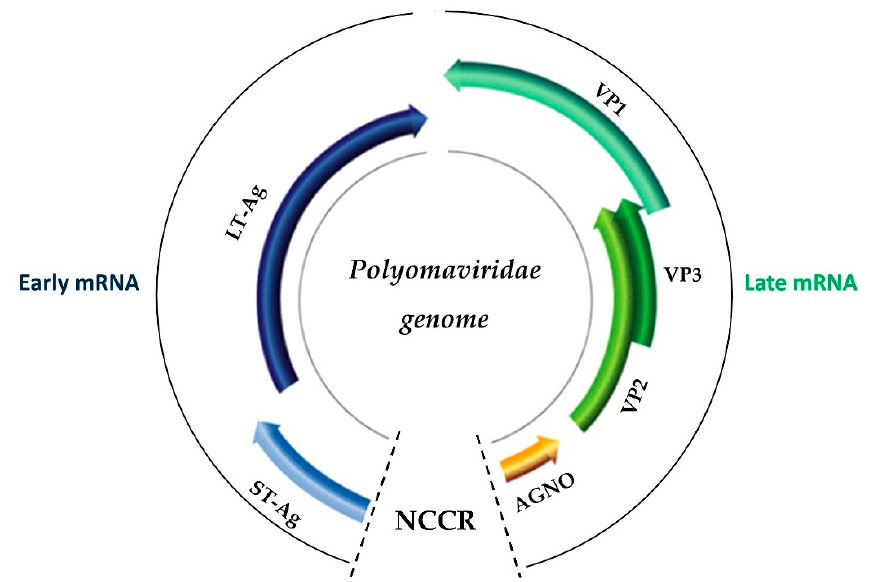
Figure 1. Schematic map of Polyomaviridae genome. The BK virus (BKV) genome is a closed circular, double-stranded DNA molecule. The transcription of early mRNA and late mRNA coding regions is a counter-direction from the origin of replication within the non-coding control region (NCCR). The early coding region encodes LT-Ag and ST-Ag, whereas the late coding region encodes AGNO protein and capsid proteins VP1, VP2, and VP3.